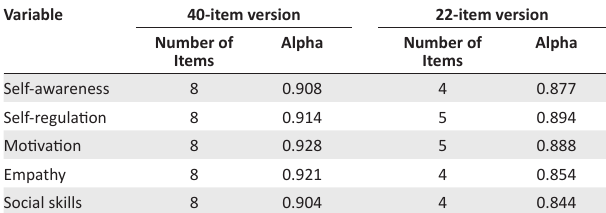
TABLE 4: Reliability estimates (Sample 1, n = 470).